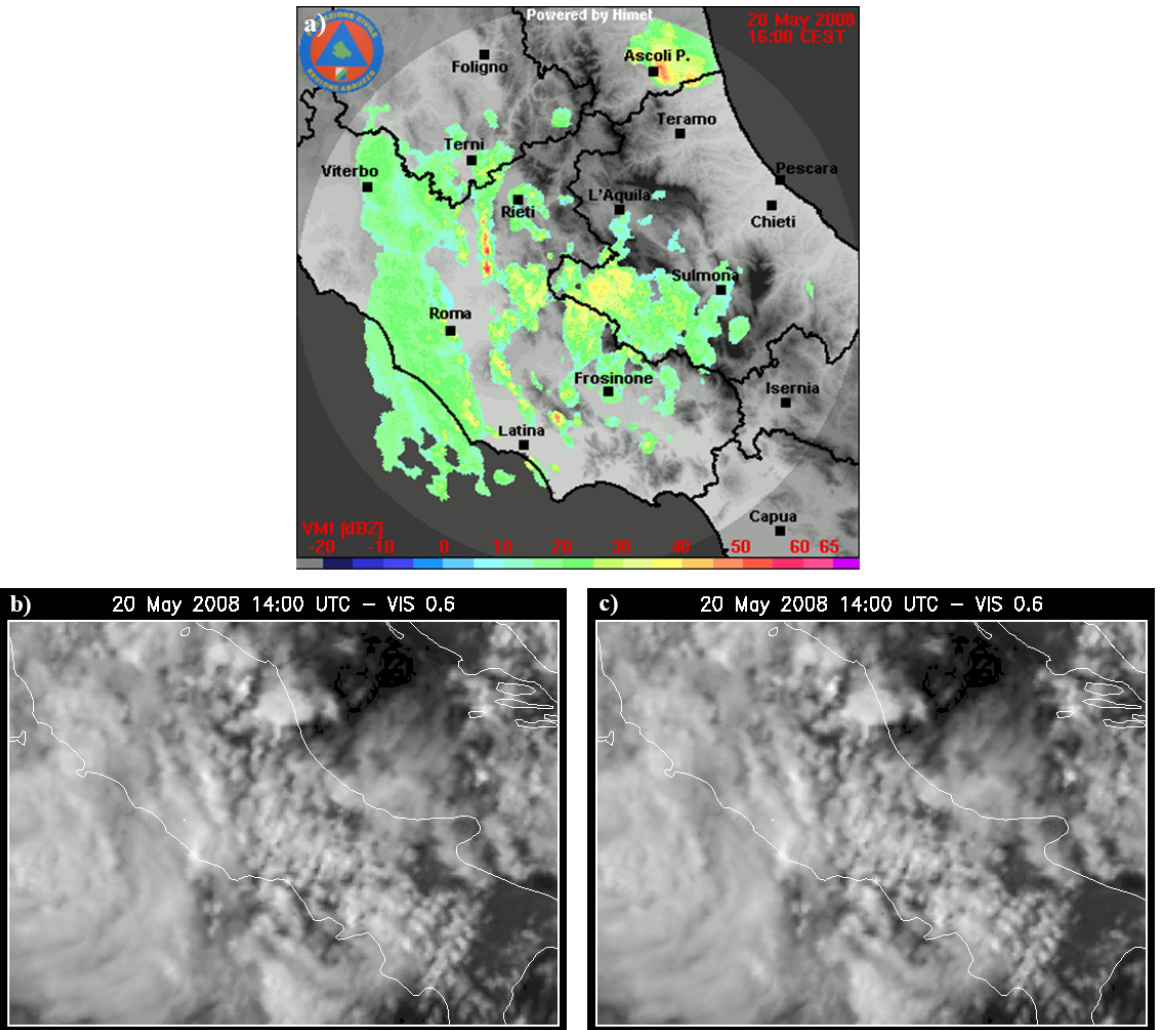
Figure 7. (a) VMI (dBZ) from the Monte Midia radar at 14:00UTC, 20 May 2008 (courtesy of Centro Funzionale of the Abruzzo region). The solid red circle and the red arrow indicate the precipitation patterns selected for the analysis. (b) Geostationary MSG map taken at 14:00UTC at the visible channel. (c) Geostationary MSG map taken at 14:00UTC at the infrared channel. The “banana-shaped” cloud structure is clearly evident over the central Tyrrhenian